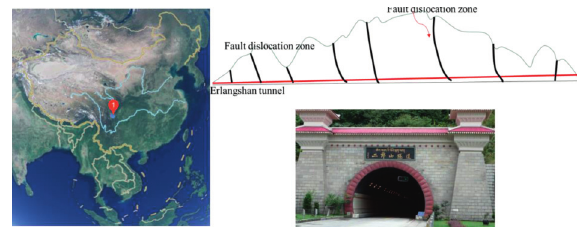
Figure 1: Tunnel location and geological